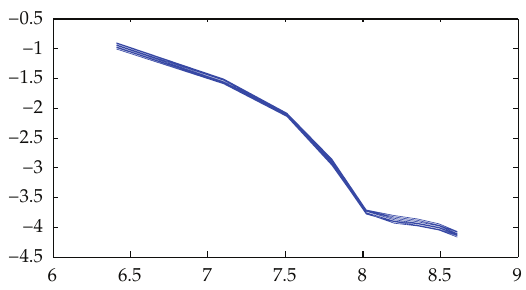
Figure 6: The fitting chart of Chinese medicine group for Fugle-Meyer baseline fractal m (cid:8) 2.